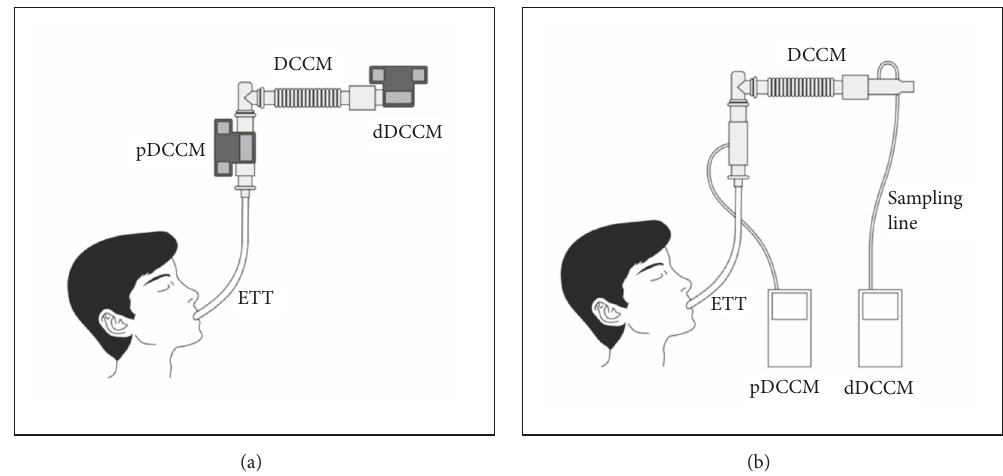
Figure 1: Schematic figures of (a) mainstream capnometers and (b) microstream capnometers . Abbreviations: DCCM, direct connect catheter mount; dDCCM, distal capnometer of direct connect catheter mount; ETT, endotracheal tube; pDCCM, proximal capnometer of direct connect catheter mount.